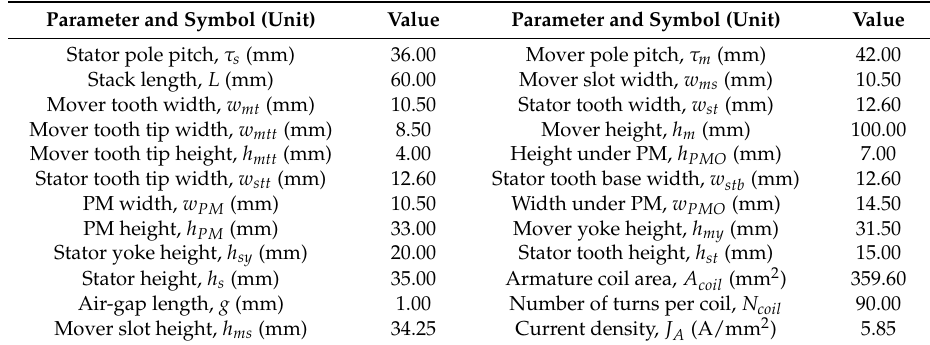
Figure 3. Design variables of DSLFSPMM. Table 1. Design parameters of DSLFSPMM.